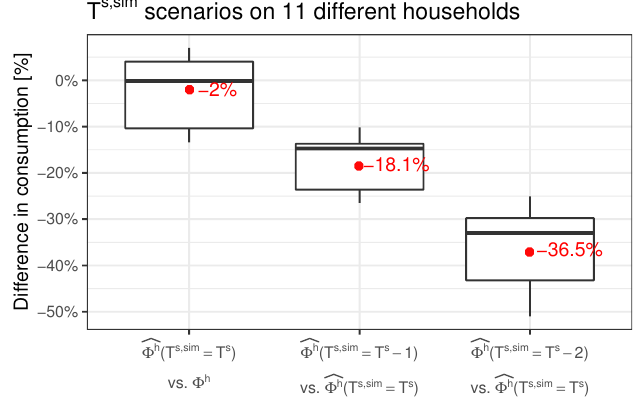
Figure 15. Energy potential savings distributions applying two different set point temperatures scenarios ( T s , sim ) over 11